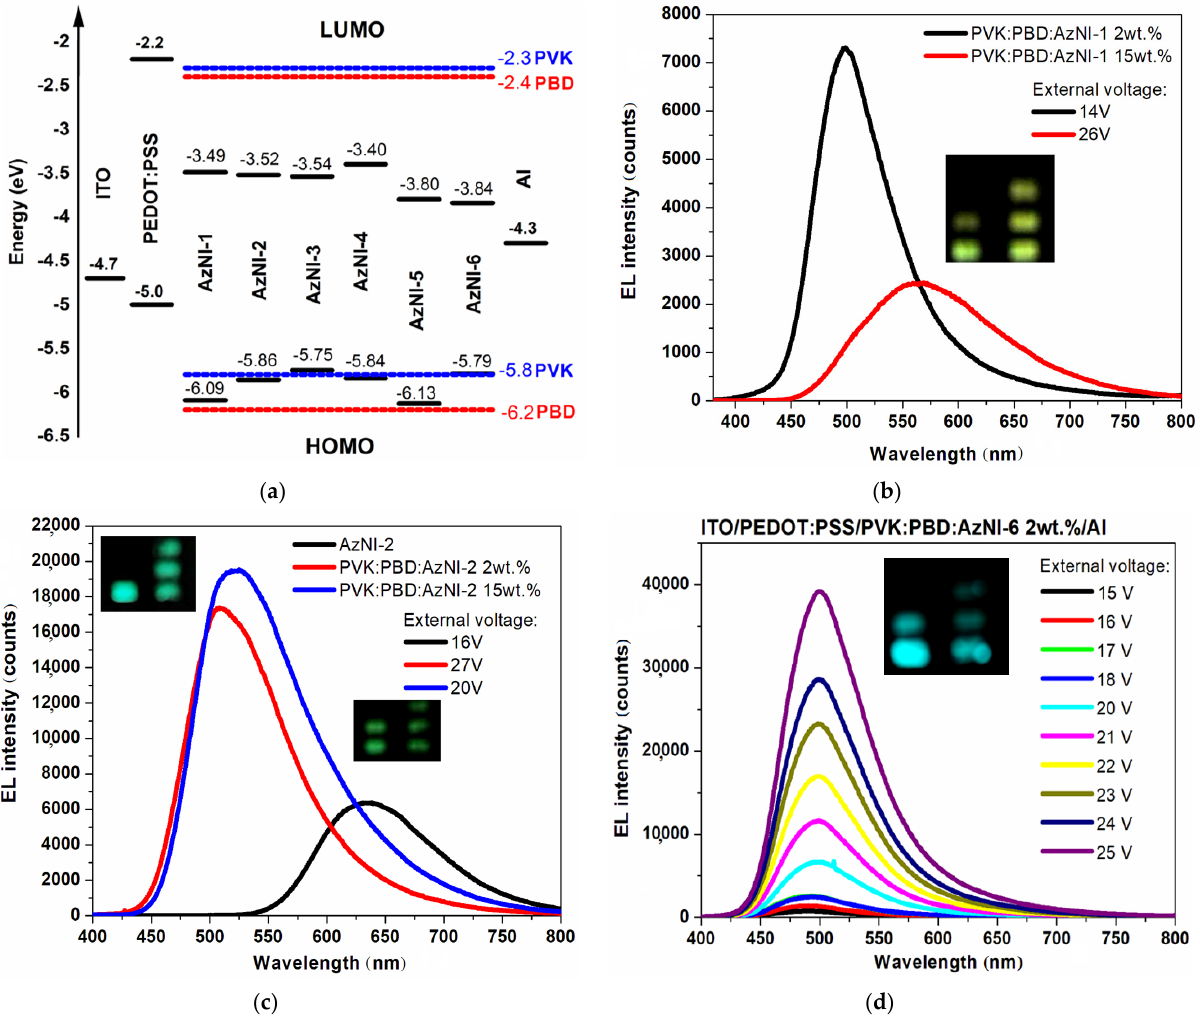
Figure 7. ( a ) The energy level diagram and EL spectra recorded from the working devices with ( b ) AzNI–1, ( c ) AzNI–2 , and ( d ) AzNI–6 with their photo under external voltage.